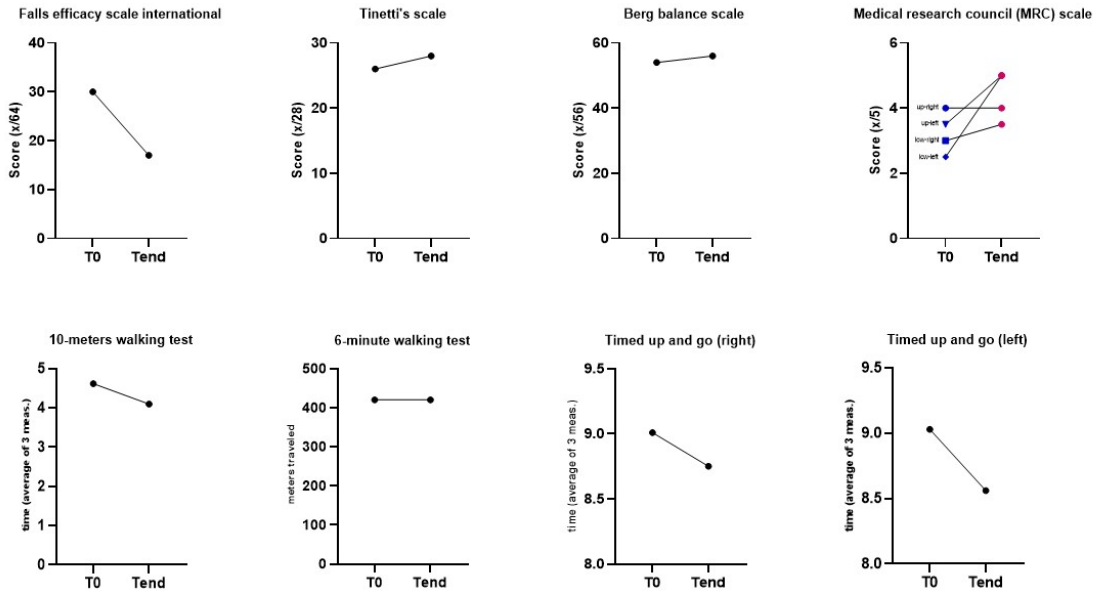
Figure 2. Changes in main scales and physical performance tests from baseline (T0) to the end of the established VR rehabilitation program (Tend). MRC scale: blue circle is the up-right limbs baseline value; blue triangle is the up-left limbs baseline value in; blue square is the low-right limbs baseline value; blue rhombus is the low-left limbs baseline